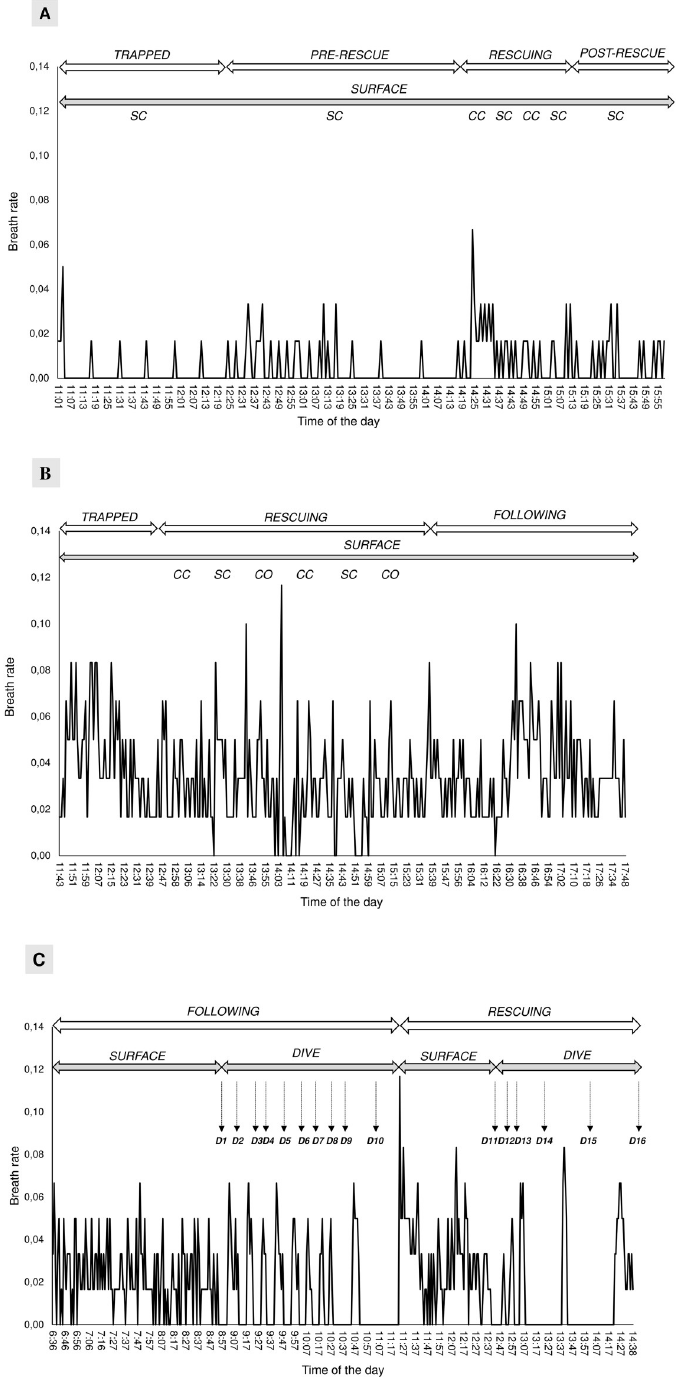
Fig 5. Breathing rate (breaths per minute bin) trend, surface or diving behaviour, and vocalization recorded. A) First whale during all phases on 26/06/2020. B) Second whale during the first day (trapped, rescuing and following on 18/07/2020). C) Second whale, second day (rescuing and following on 19/07/2020). SC = single clicks; CC = creaks; CO = codas. Dives are indicated as D followed by a sequential number.